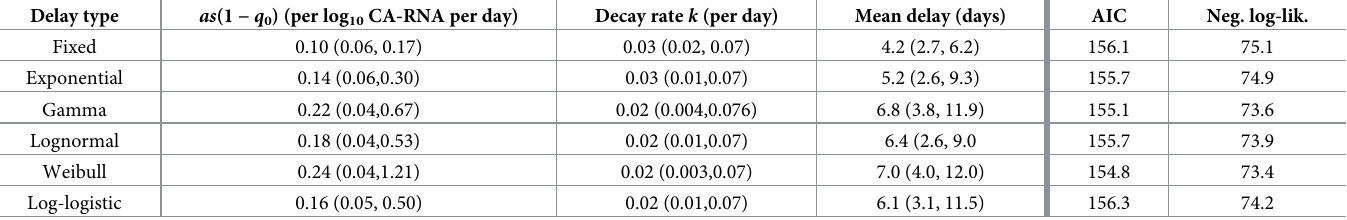
Table 3. Key parameter estimates for model (1) with the 95% confidence interval indicated in parentheses, distinguishing study participants based on pre-ATI ART regimen, specifically inclusion of NNRTIs. Distribution-specific parameter estimates provided in S2 Table. Delay type as (1 − q 0 ) (per log 10 CA-RNA per